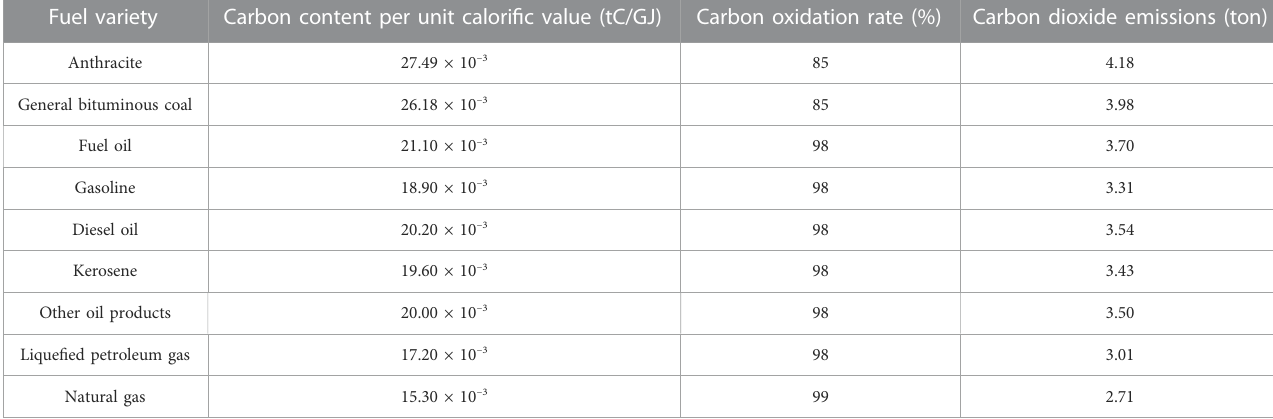
TABLE 2 Carbon content, carbon oxidation rate, and carbon dioxide emission of different fossil fuels.